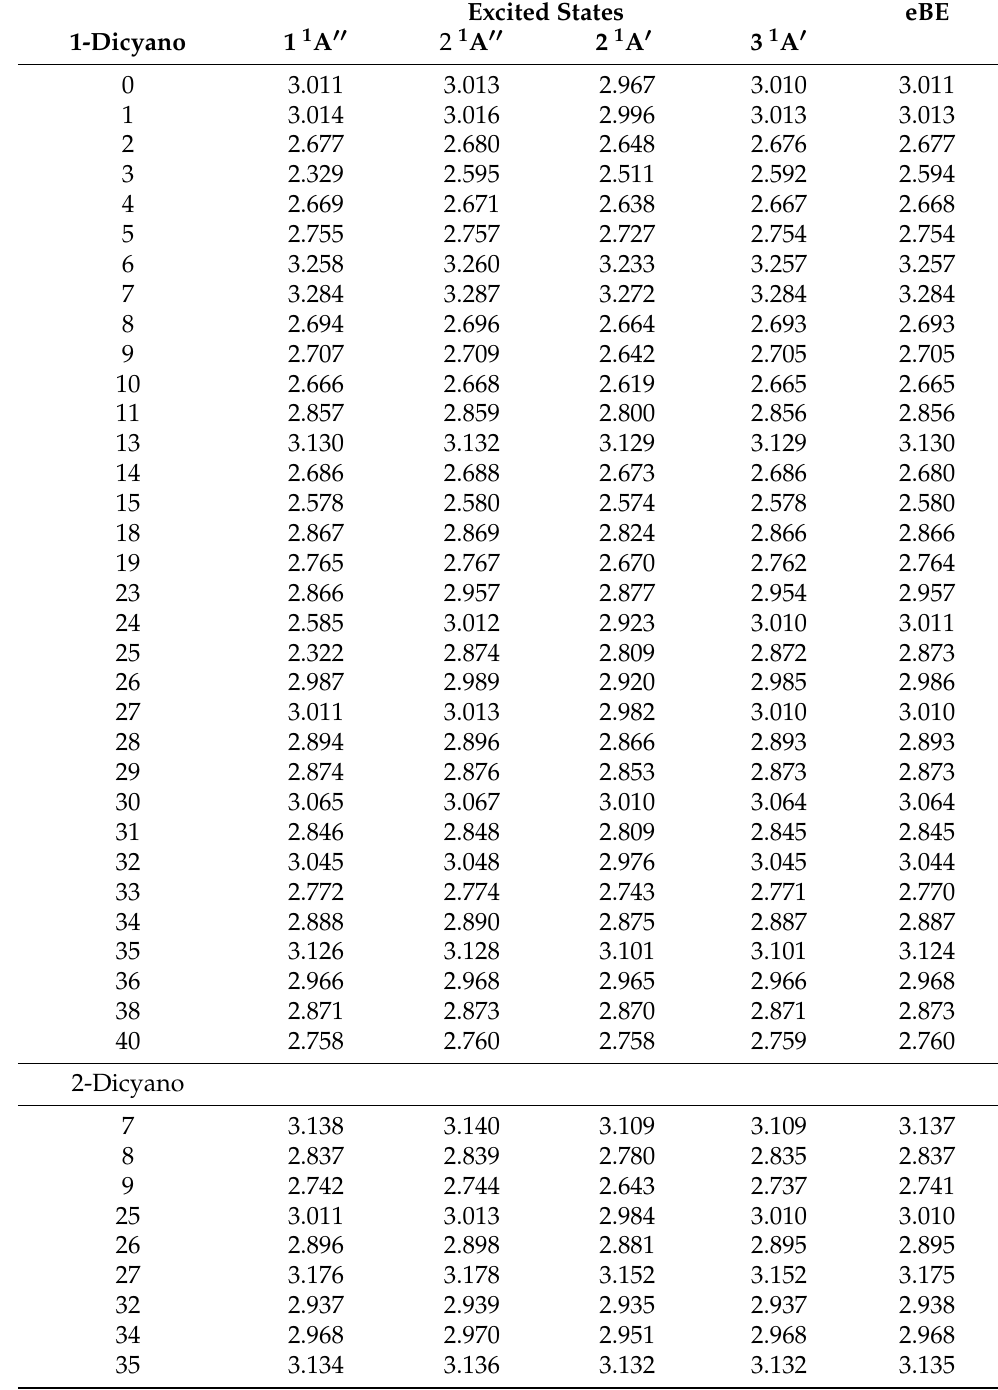
Table 4. EOM-CCSD/apvdz+8s6p3d electronically excited states and electron binding energies (all in eV) of the dicyanonaphthalene